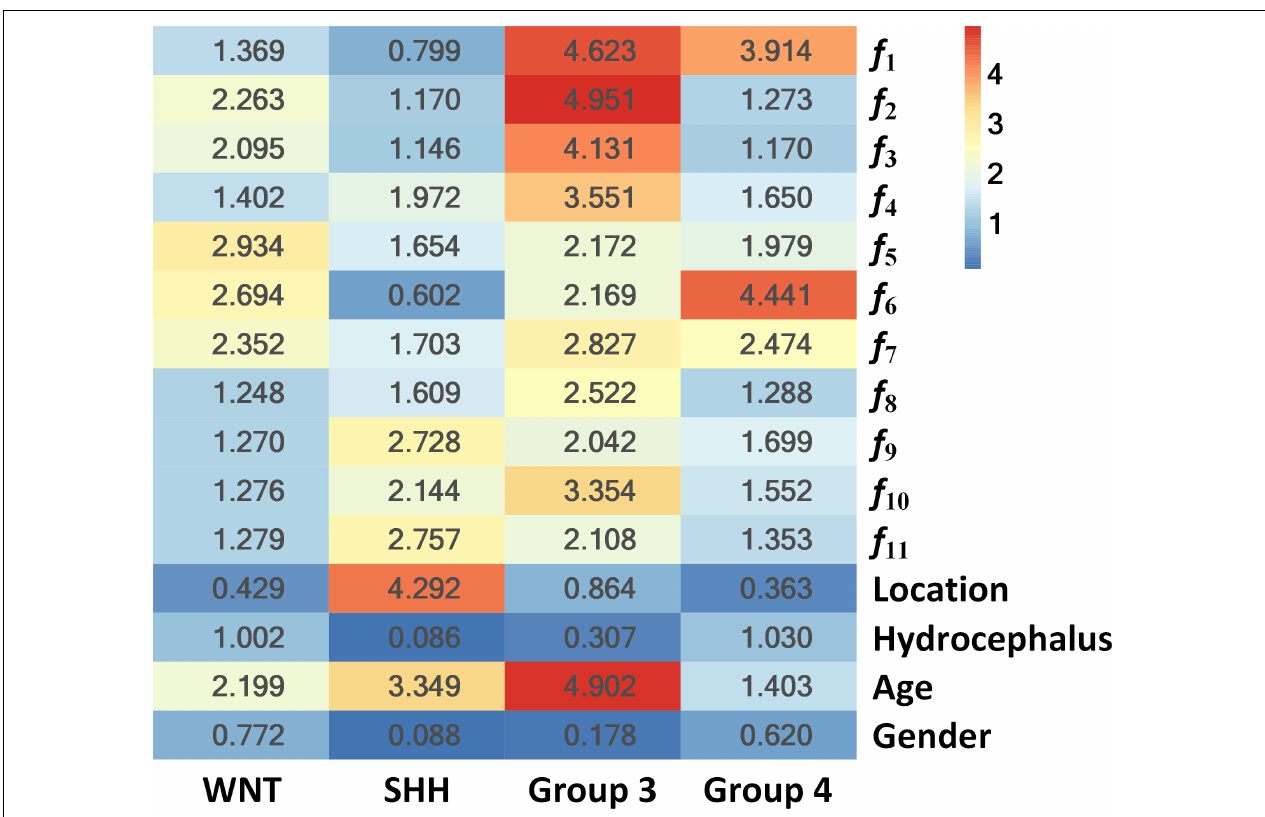
FIGURE 4 | Heat map of the subgroup-specific importance of all parameters used in subgroup